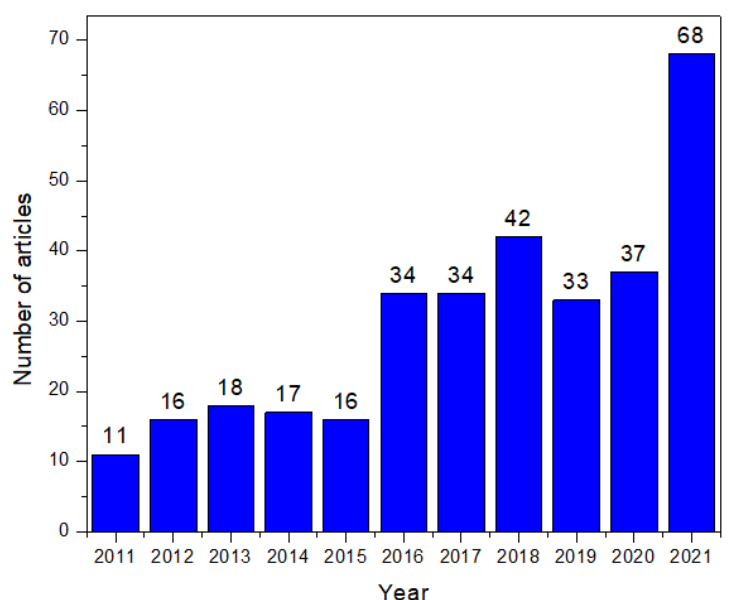
Figure 1. Number of empathic and empathetic articles per year (duplicates excluded).